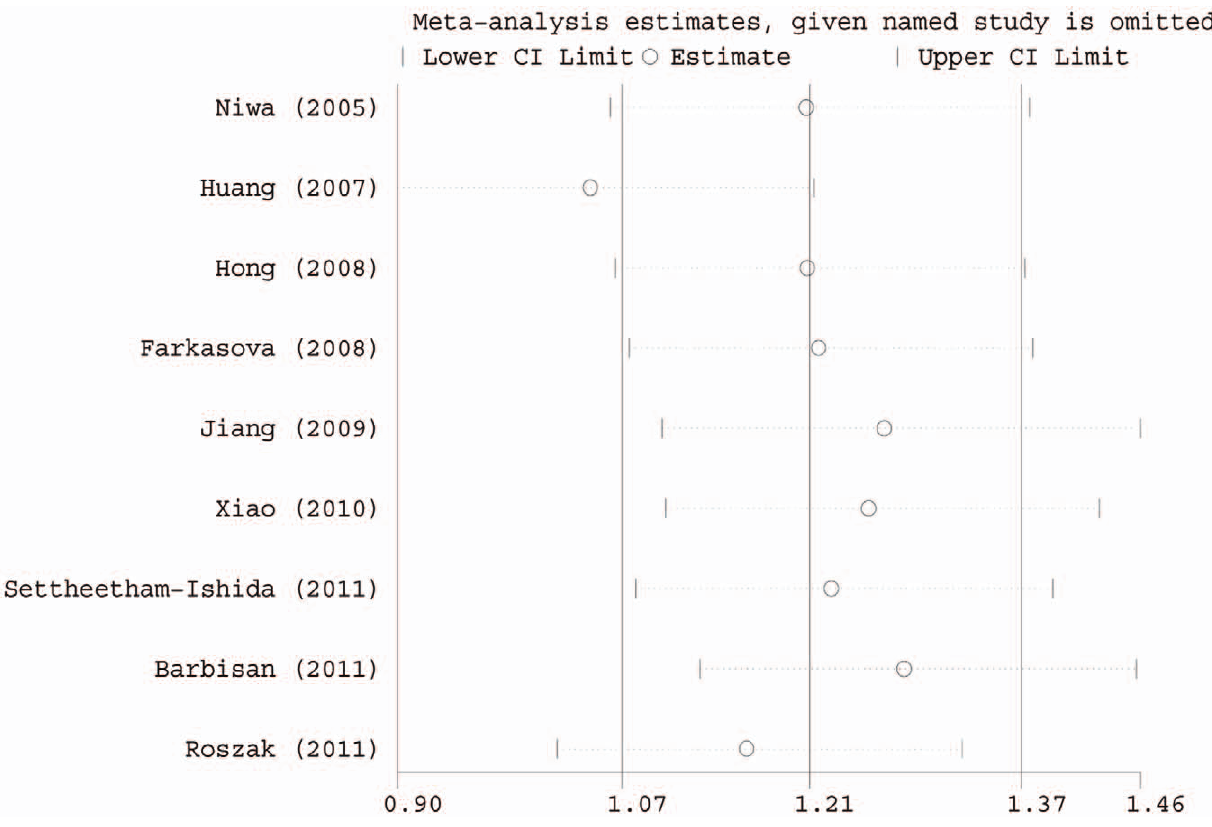
Figure 3. Influence analysis of the summary odds ratio coefficients on the association between x-ray repair cross-complementing group 1 gene (XRCC1) Arg399Gln GG-plus-GA genotypes with cervical cancer risk. Results were computed by omitting each study (left column) in turn. Bars, 95% confidence interval.